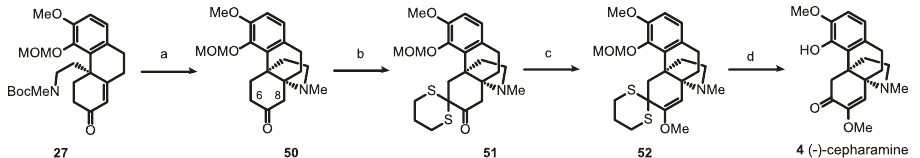
Fig. 6 Total synthesis of (-)-cepharamine ( 4). Reagents and conditions: (a) TMSOTf (3.0 equiv), 2,6-lutidine (5.0 equiv), DCM, 0 °C to rt, then TBAF (3.0 equiv), 0 °C, 77%; (b) KO t Bu (2.0 equiv), Et 2 O/HCO 2 Et = 10/1, 0 °C to rt, then trimethylene dithiotosylate (1.0 equiv), AcOK (10.0 equiv), MeOH, re fl ux, 62%; (c) KO t Bu (3.0 equiv), Me 2 SO 4 (1.1 equiv), DMSO, rt, 85%; (d) PIFA (2.5 equiv), TFA (2.0 equiv), MeCN/H 2 O = 1/1, then TFA, rt, 91%. TMSOTf trimethylsilyl tri fl uoromethanesulfonate, TBAF tetra- n -butylammonium fl uoride, DMSO dimethyl sulfoxide, PIFA [bis(tri fl uoroacetoxy)iodo]